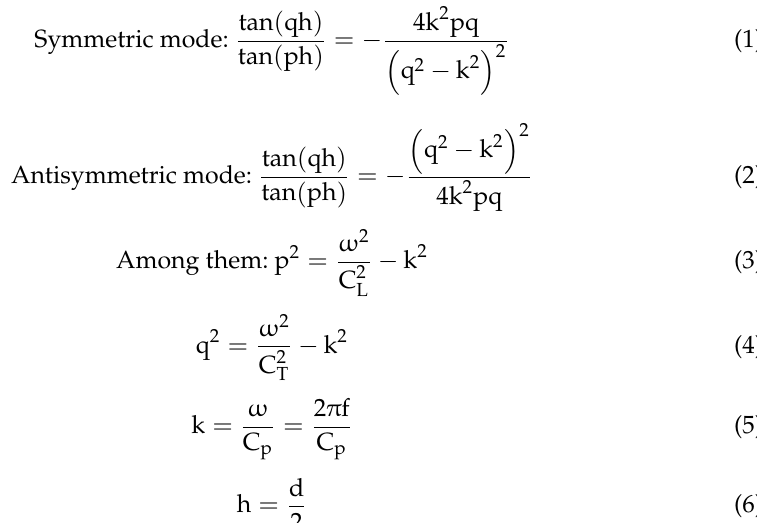
Figure 3. Schematic diagram of the propagation of UGWs in a plate structure. According to the different distribution patterns of the vibration displacement of the particles in the plate, Lamb waves can be divided into a symmetric mode and an antisymmetric mode. When the symmetrical Lamb wave propagates through the plate, the particle in the centre of the plate moves longitudinally, while the particles on the upper and lower surfaces both vibrate elliptically with opposite phases and symmetry than the centre; their dispersion equations are represented by Equations (1) and (2) [22,23].